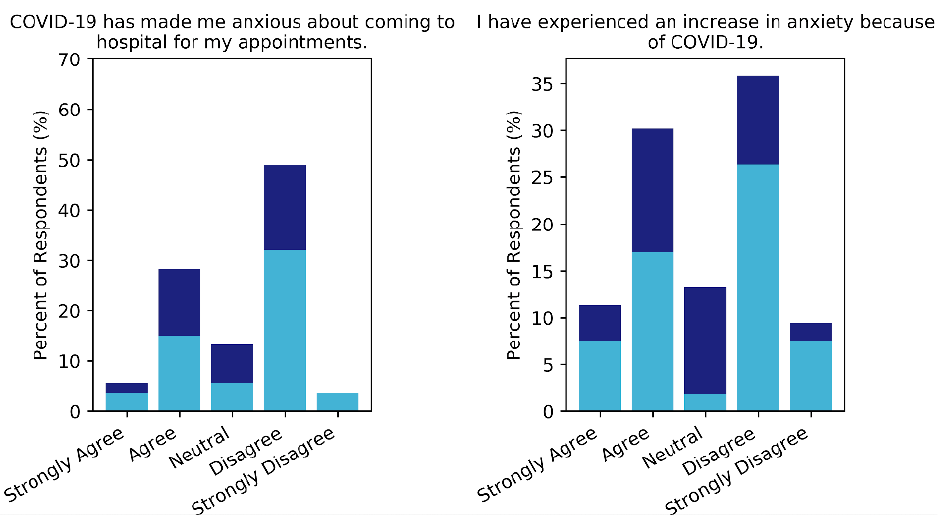
Figure 1. Responses to questions about patient anxiety due to COVID-19. Online responses are shown in indigo and phone responses in sky